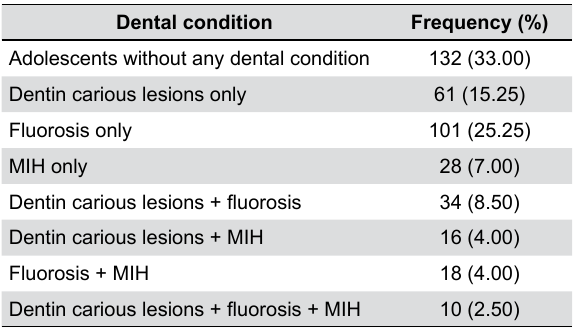
Table 3- Distribution of participants according to the three dental conditions evaluated